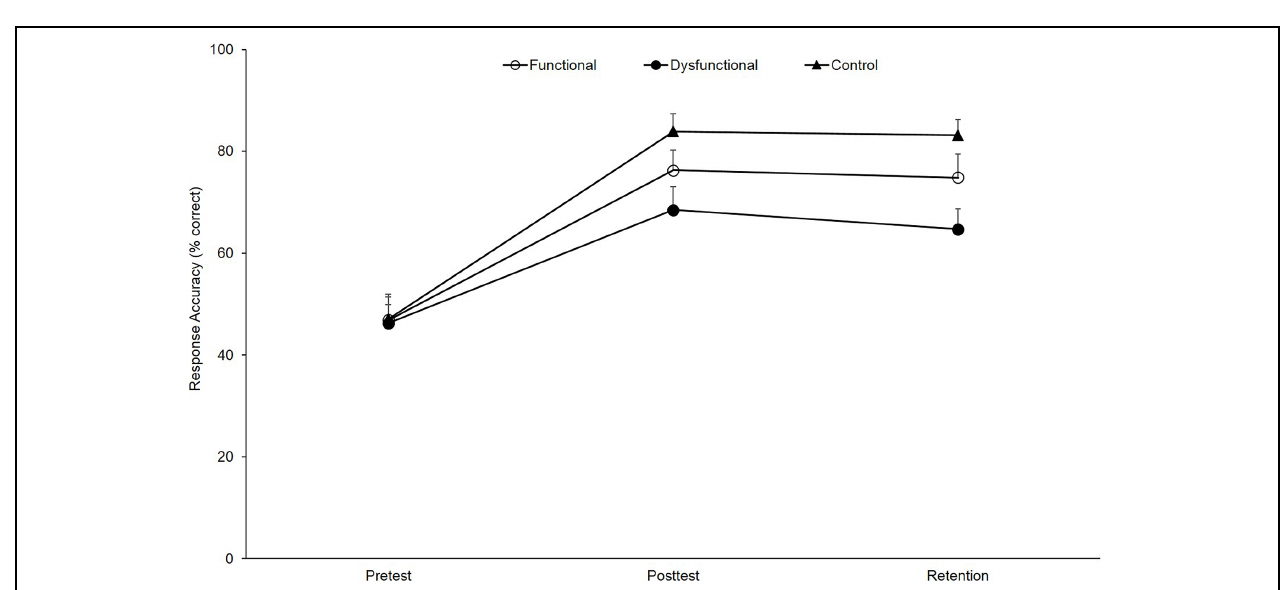
FIGURE 5 | Gaze-path index (GPI) ( M and SE , in ◦ visual angle) as a function of group (functional, dysfunctional and control), test (pre-, post-, and retention test), and phase (P1 and P2). The dashed lines represent the values that were achieved if the gaze perfectly followed either the functional (lower line) or the dysfunctional (upper line) cue path.